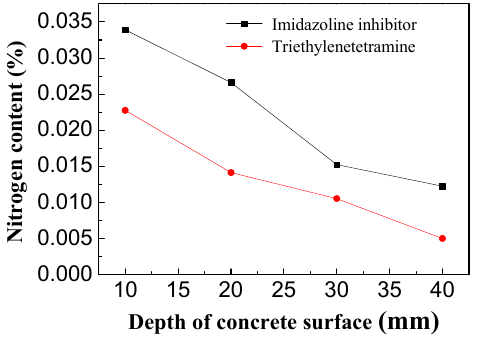
Figure 13. Inhibitor content in concrete.